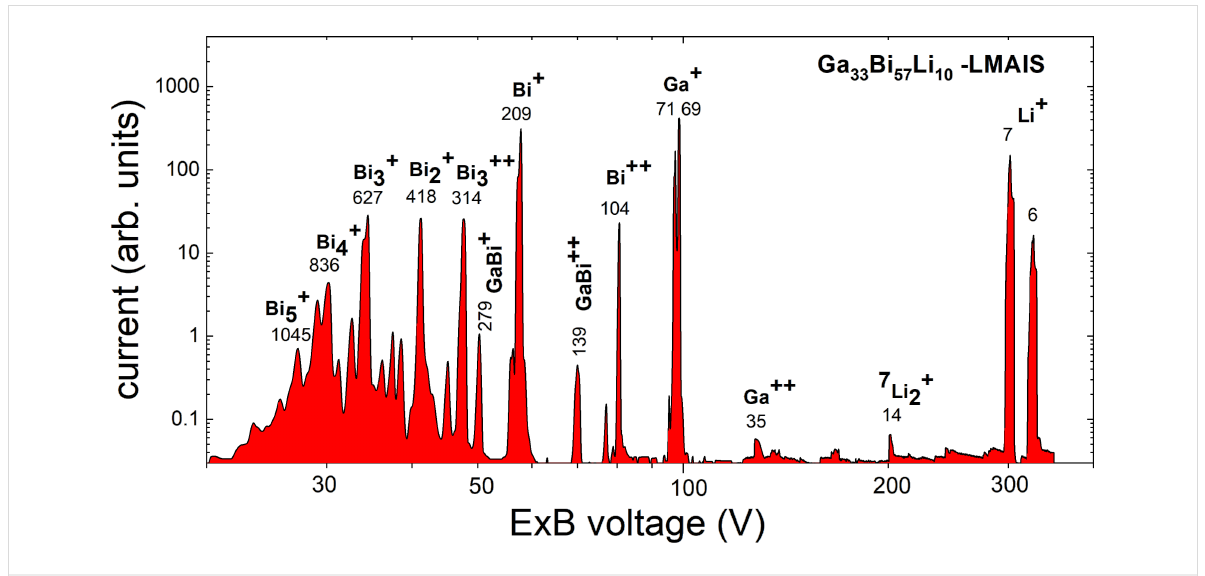
Figure 2: Mass spectrum of a Ga 33 Bi 57 Li 10 LMAIS at an acceleration potential of 10 kV scanned by the ExB voltage using a constant magnetic field. The numbers below the ion label specify the total ion mass m in